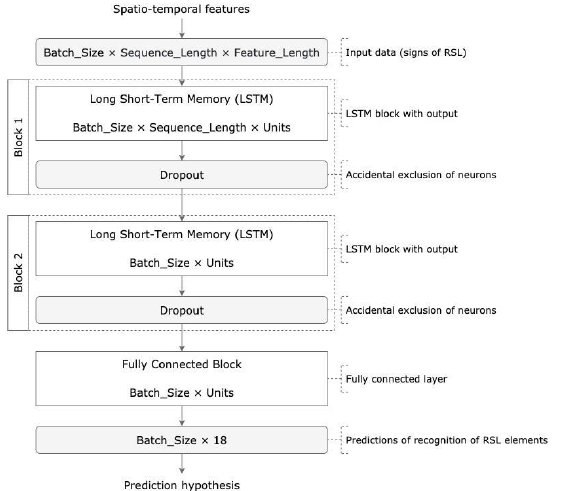
Figure 5 . Architecture of the LSTM neural network model for RSL elements recognition.